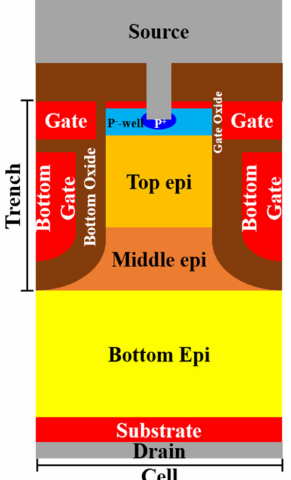
Figure 3. The cross-section diagram of a triple-EPIs SGT power